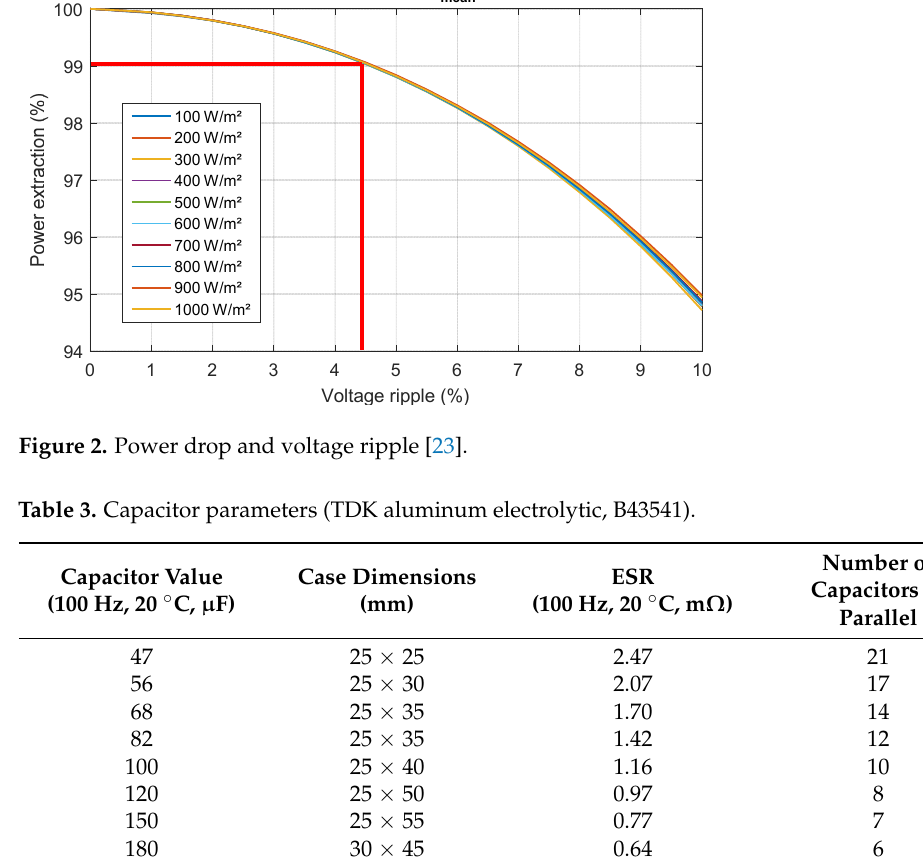
Table 3. Capacitor parameters (TDK aluminum electrolytic, B43541).